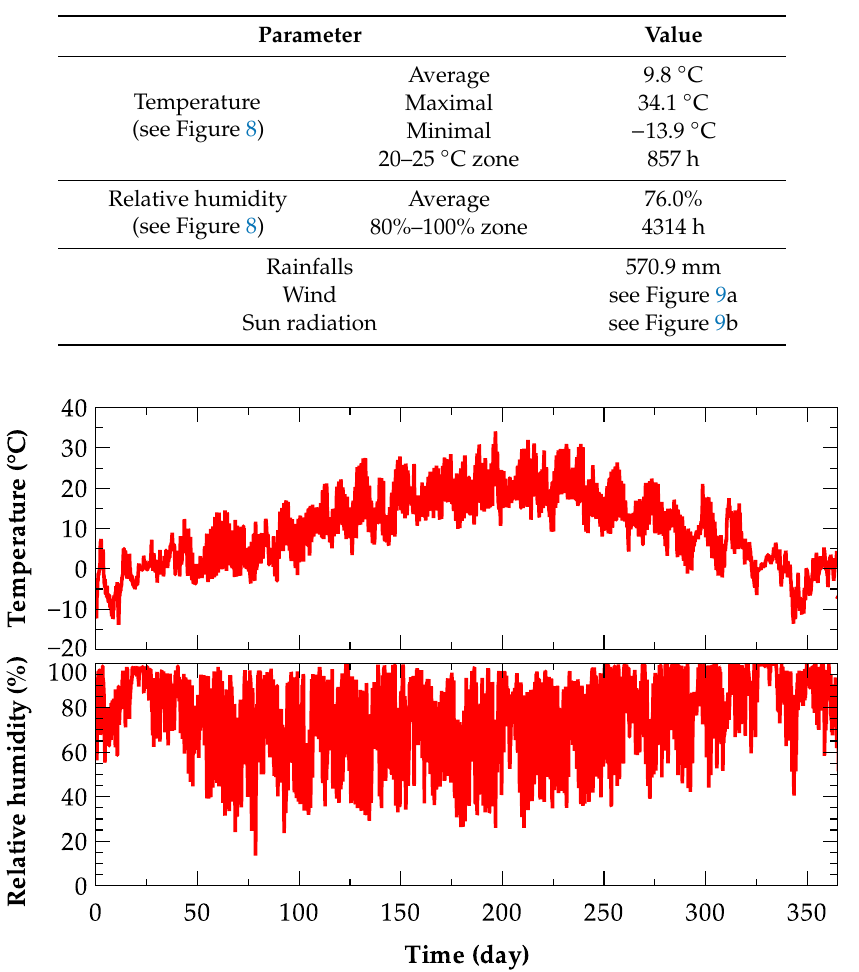
Figure 8. Reference weather data of Olomouc, Czech Republic: temperature and relative humidity.